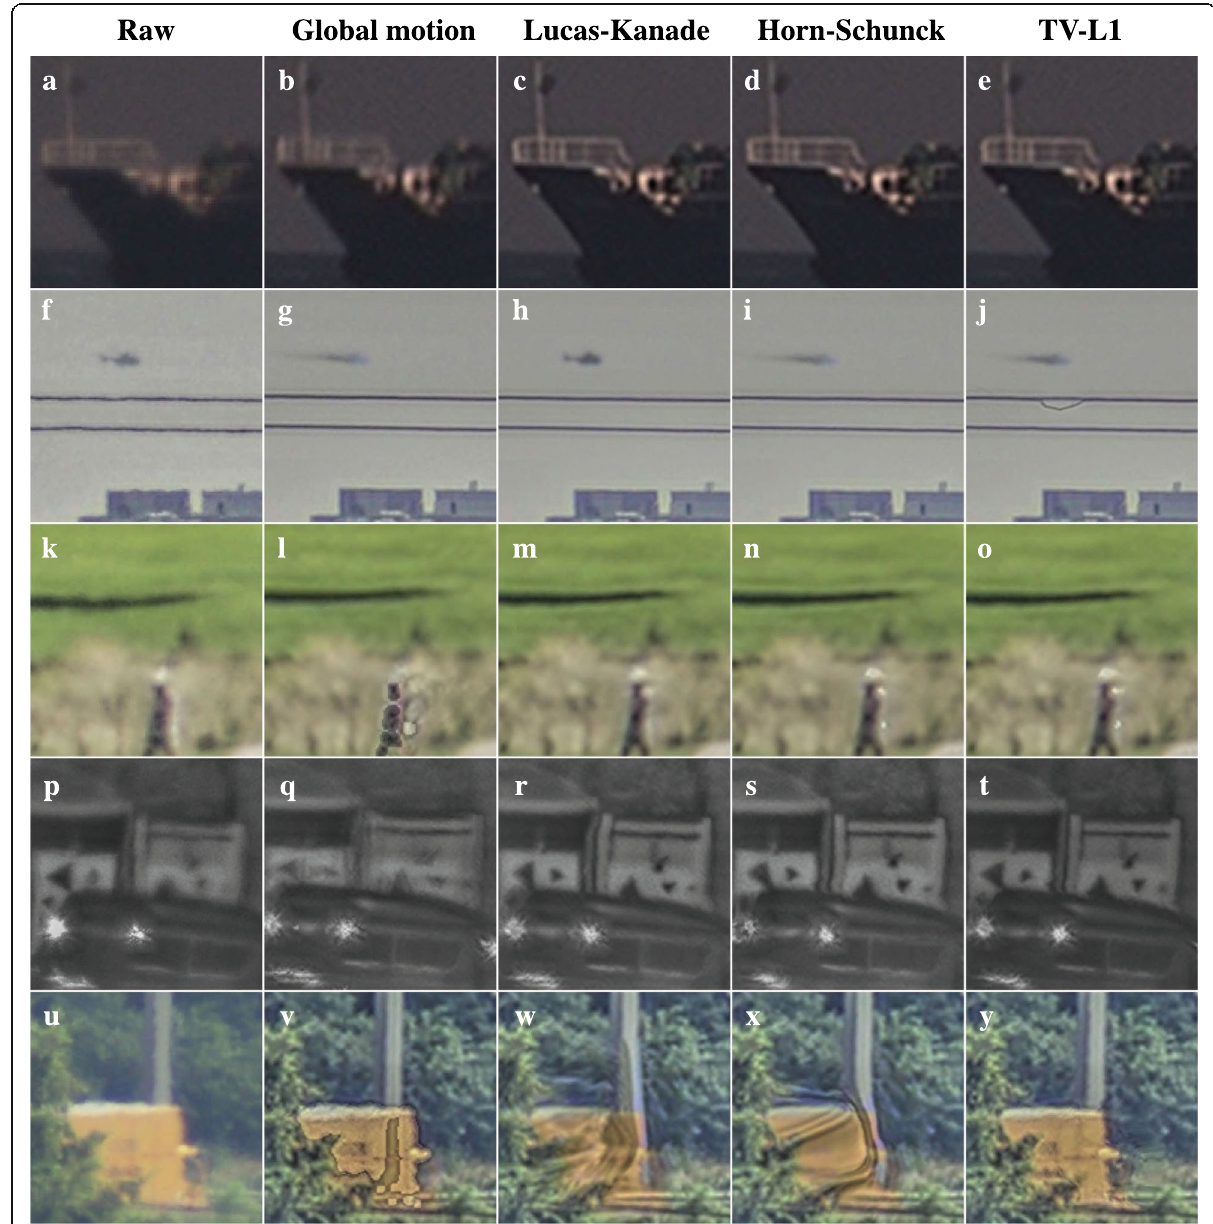
Fig. 11 Application of the different motion estimation methods to each of the datasets in this article. Each column ( a - y ) shows the results in a representative region of interest for one of the motion estimation methods. The leftmost column shows the corresponding area in the raw input